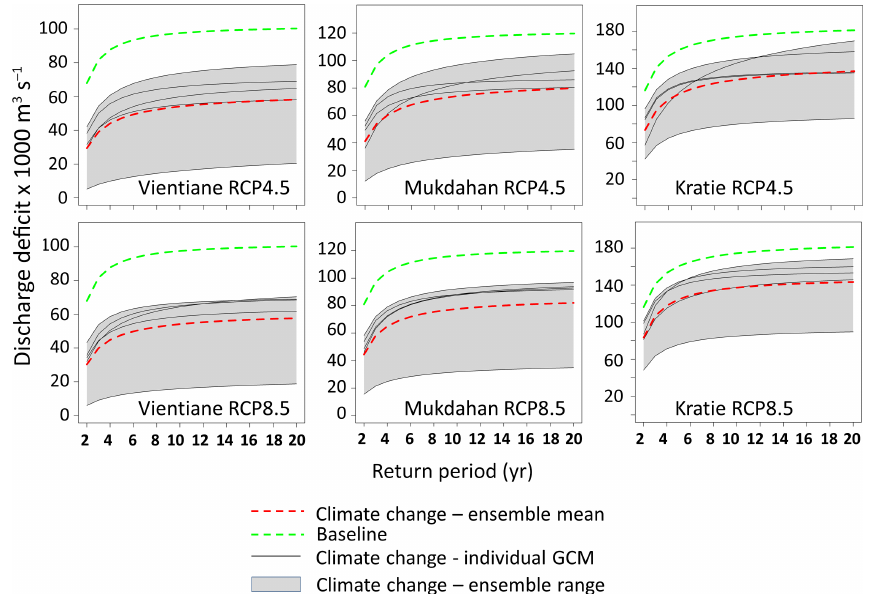
Figure 8. Non-exceedance curves of yearly maximum cumulative discharge deficits (i.e. total deficit below the Q 75 threshold) under baseline and future